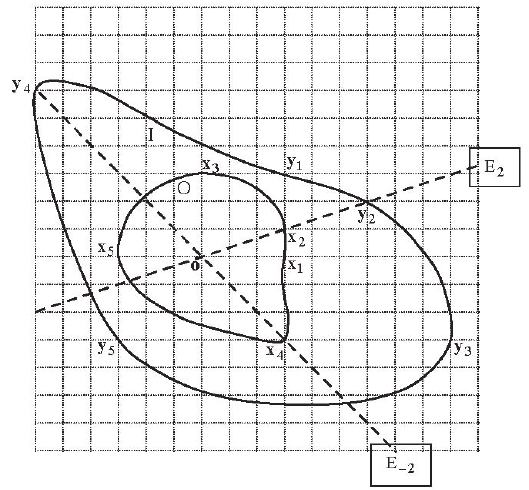
Figure 2 O is the outline of an object on which the points rep- resented by vectors x , x , x , etc, lie. I is the outline of the 1 2 3 image of the object having been magnified by magnification 31     −= X ; on it points represented by y , y , y , etc, lie. 1 2 3 11 Along E and 2 E − there is magnification by 2 and 2 − respec- 1 tively and no rotation; 2 and 2 − are the eigenvalues of X and E 1 and 2 E − the corresponding